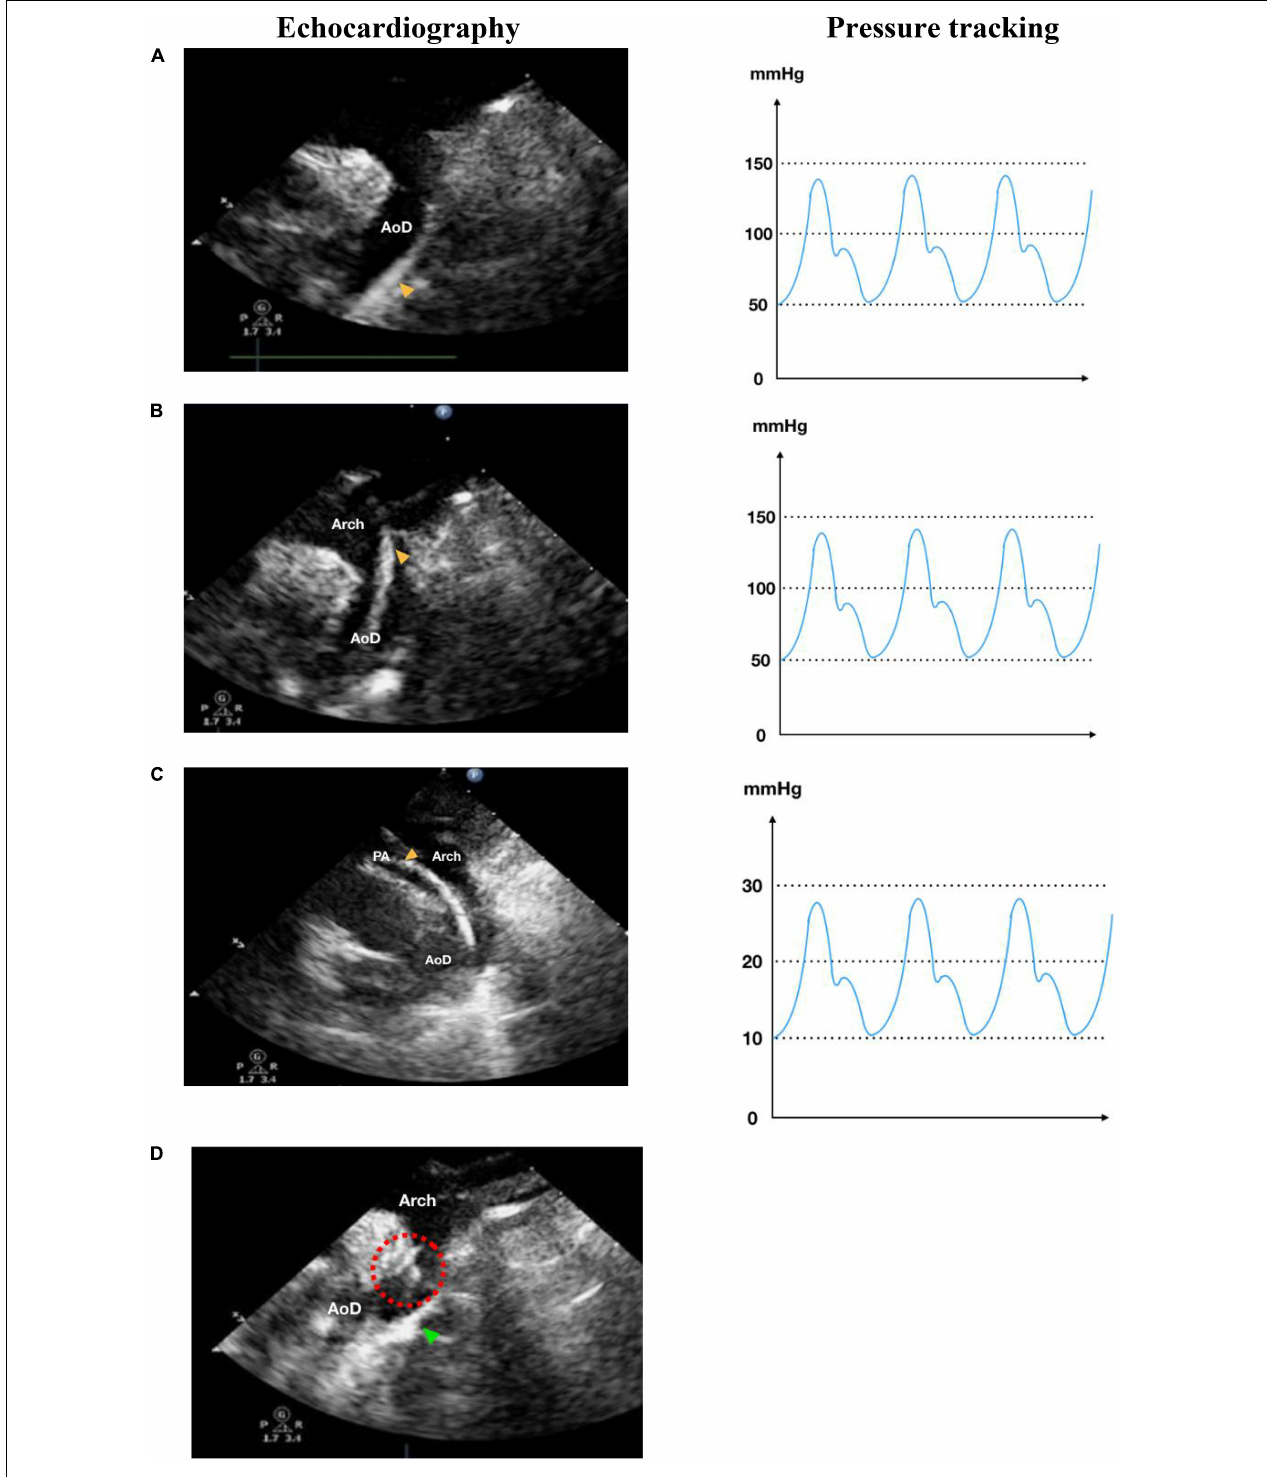
FIGURE 3 | Retrograde transarterial approach of percutaneous patent ductus arteriosus (PDA) closure. (A) Catheter is seen in AoD in TTE arch view. (B) Catheter is pushed towards the aortic arch in TTE arch view. (C) In parasternal short axis TTE view as high as the great arteries, the catheter is seen in PA through PDA from AoD. (D) In TTE arch view, the device is stowed in place (shown by red dotted circle) after being delivered from the delivery cable. IVC, inferior vena cava; RA, right atrium; RV, right ventricle; PA, pulmonary artery; Ao, aorta; LA, left atrium; LV, left ventricle; AoD, descending aorta; PDA, patent ductus arteriosus. Orange arrowhead shows the catheter head. Green arrowhead indicates the occluder device.